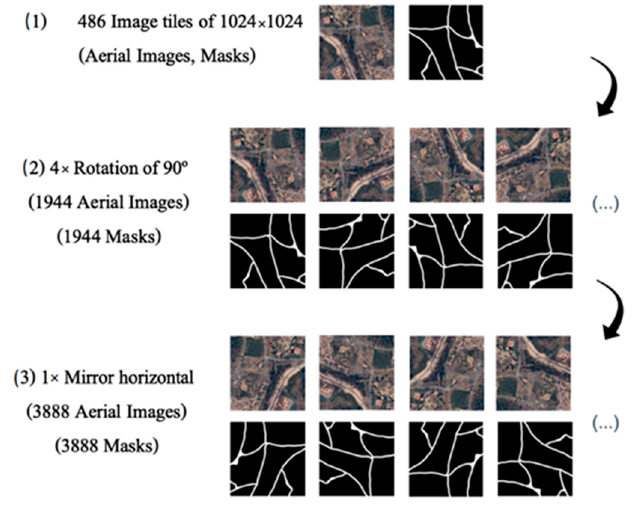
Figure 4. Enlargement of the dataset with a data augmentation procedure.